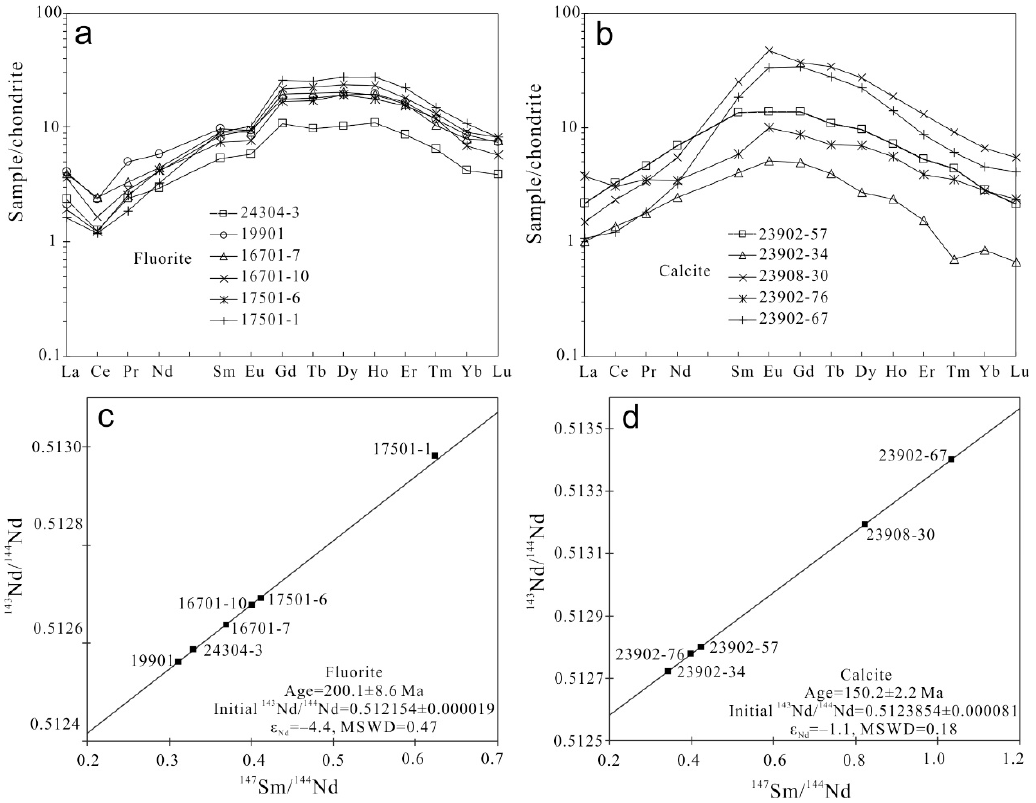
Figure 5. Chondrite-normalized REE patterns ( a , b ) and corresponding Sm–Nd isochron ages ( c , d ) for fluorite and calcite from the Shuiyindong deposit.